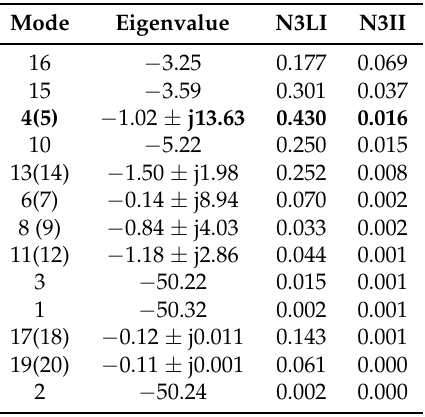
Table 3. 3rd-order NF indices for modal interaction.